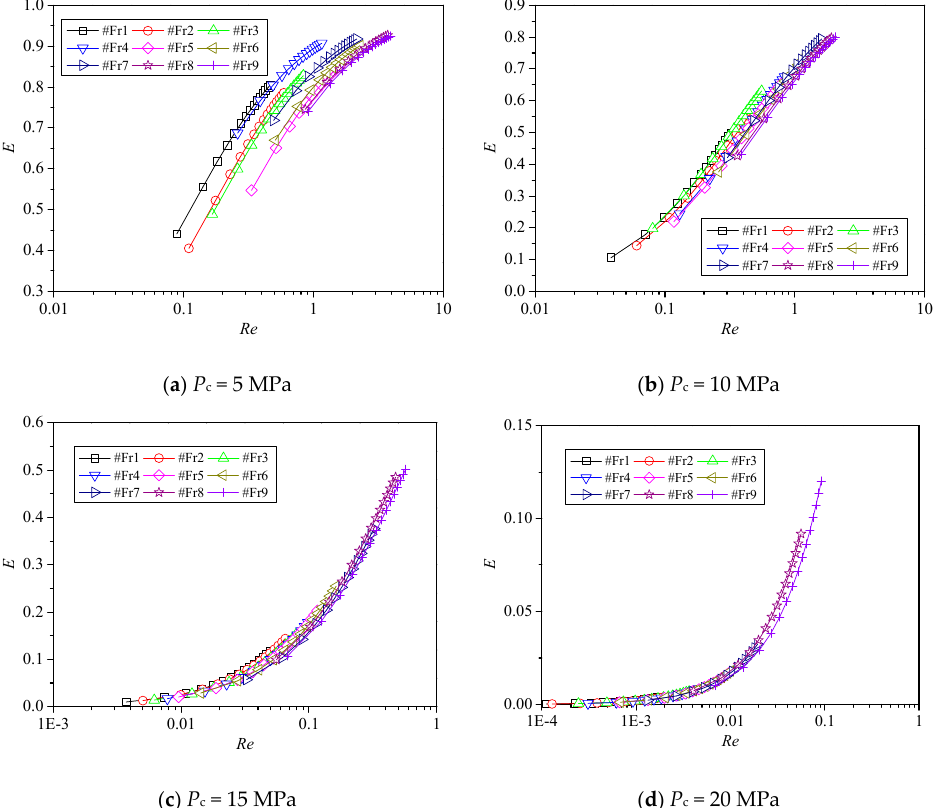
Figure 8. Relationships between factor E and the Reynolds number.